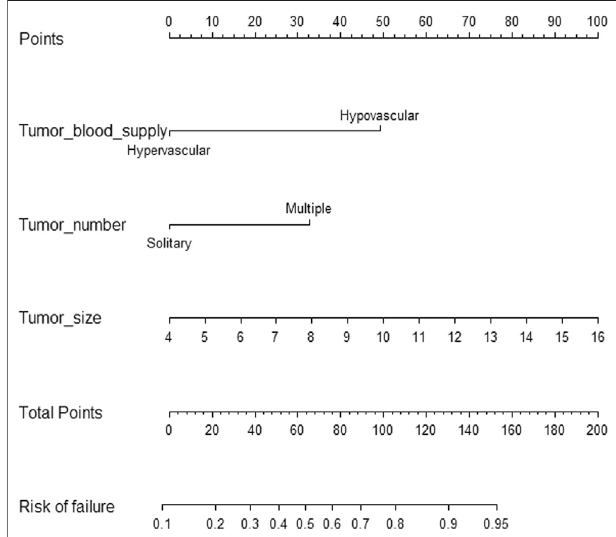
signi fi cant predictors of the failure of tumor shrinkage in response to TAE.